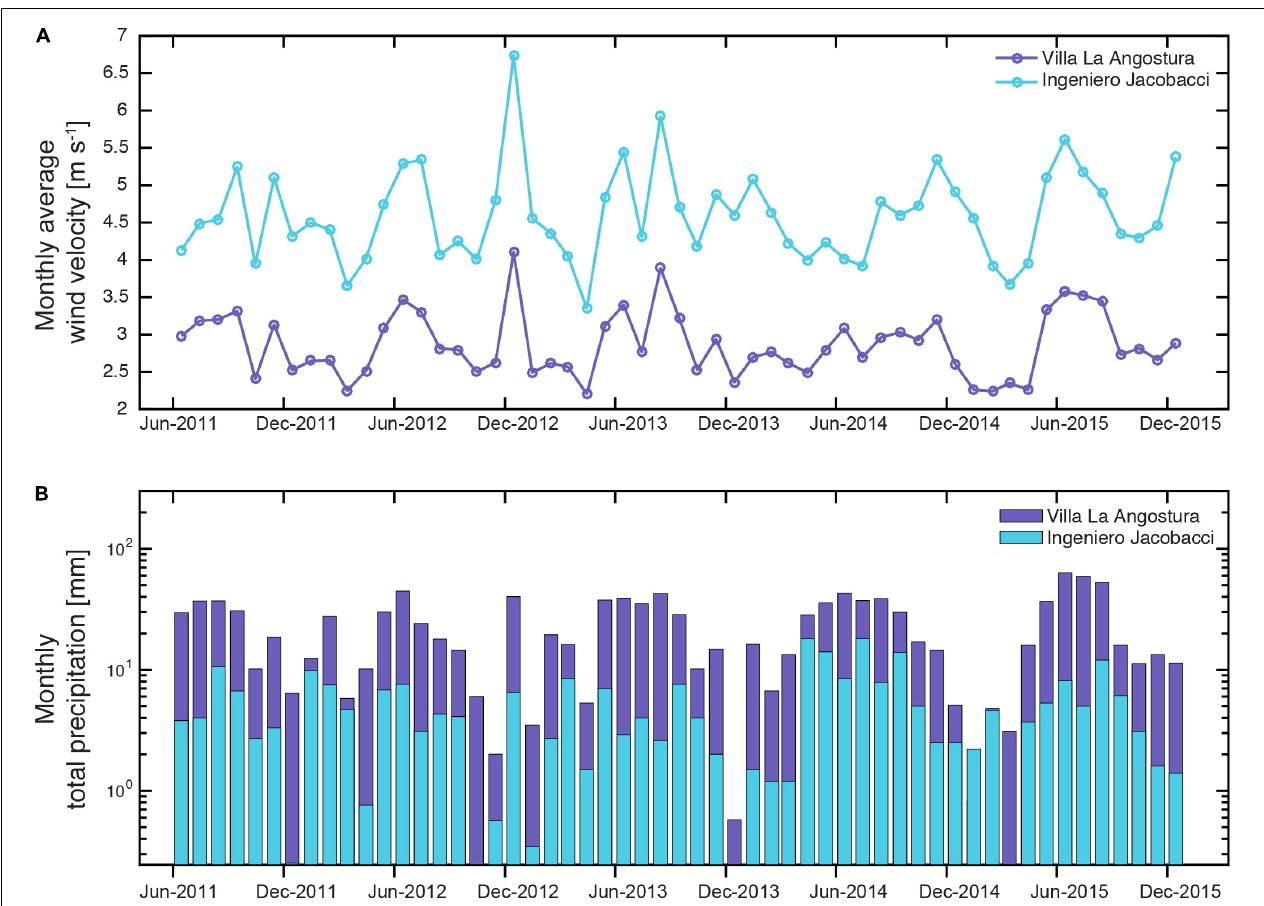
FIGURE 4 | (A) Monthly averaged wind velocity and (B) monthly total precipitation for two localities, Villa la Angostura and Ingeniero Jacobacci. Prevailing wind direction is west to east. Meteorological data from the ECMWF (European Centre for Medium-range Weather Forecasts) ERA-Interim reanalysis